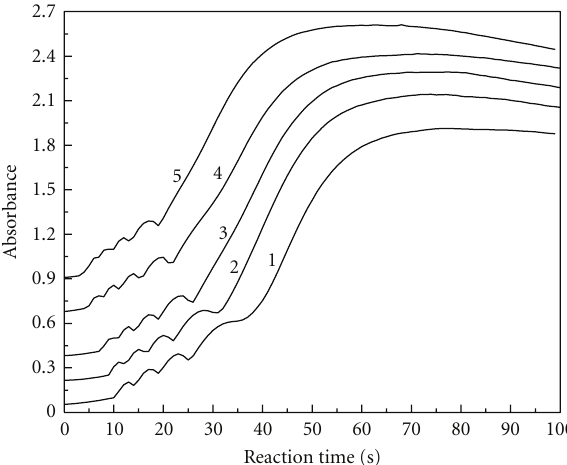
Figure 8: The absorbance versus reaction time at 289nm for the triiodide ion: [ClO 2 ] 0 = 1.92 × 10 − 3 mol/L, [MAA] 0 = 3.93 = 4.14 × 10 − 3 mol/L, [KI] = 3.22 × × 10 − 3 mol/L, [H 2 SO 4 ] 0 0 10 − 3 mol/L, 25 ◦ C (curve 1), 30 ◦ C (curve 2), 35 ◦ C (curve 3), 45 ◦ C (curve 4), 55 ◦ C (curve 5).